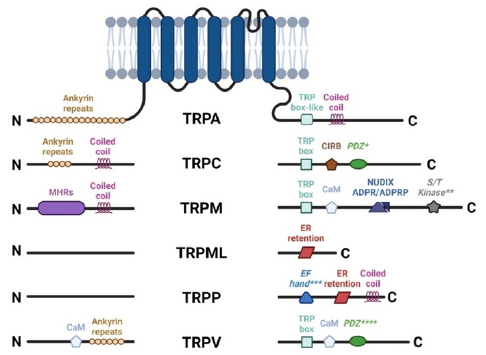
Figure 2. TRP channel architecture. The cytoplasmic N and C termini contain different structural and functional elements, for each subfamily. TRP Box, EWKFAR in TRPCs; AnkR, ankyrin repeats; CC, coiled-coil domain; S/T Kinase, intrinsic serine/threonine kinase (** for TRPM6 and TRPM7); CIRB, calmodulin and inositol triphosphate receptor binding site (InsP3R); PDZ, amino acid motif-binding PDZ domains (* for TRPC4, 5 and **** for TRPV3); NUDIX, NUDT9 homology domain binding ADP ribose or ADPR-2’-phosphate (ADPRP); EF Hand (*** for TRPP1), canonical Ca 2+ binding domain in TRPP1/PKD2; ER retention, endoplasmic reticulum retention signal.